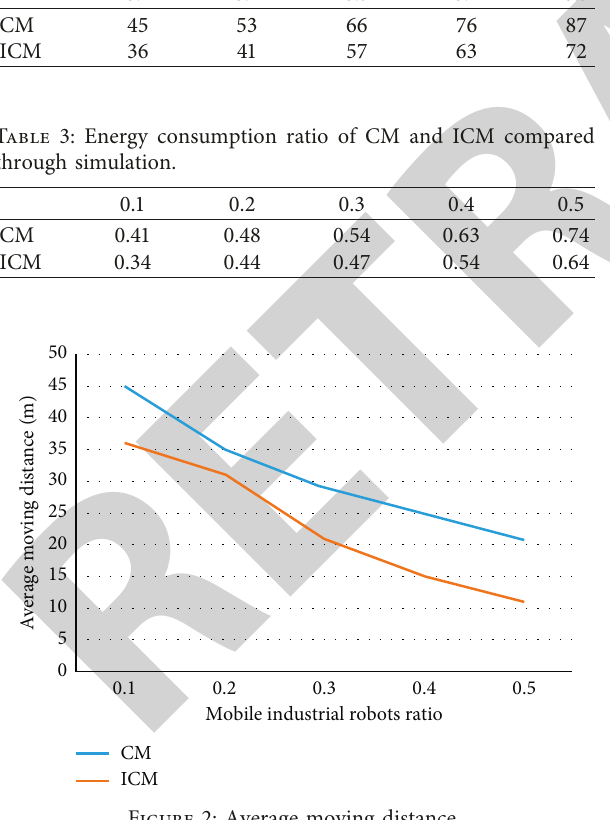
Figure 2: Average moving distance.